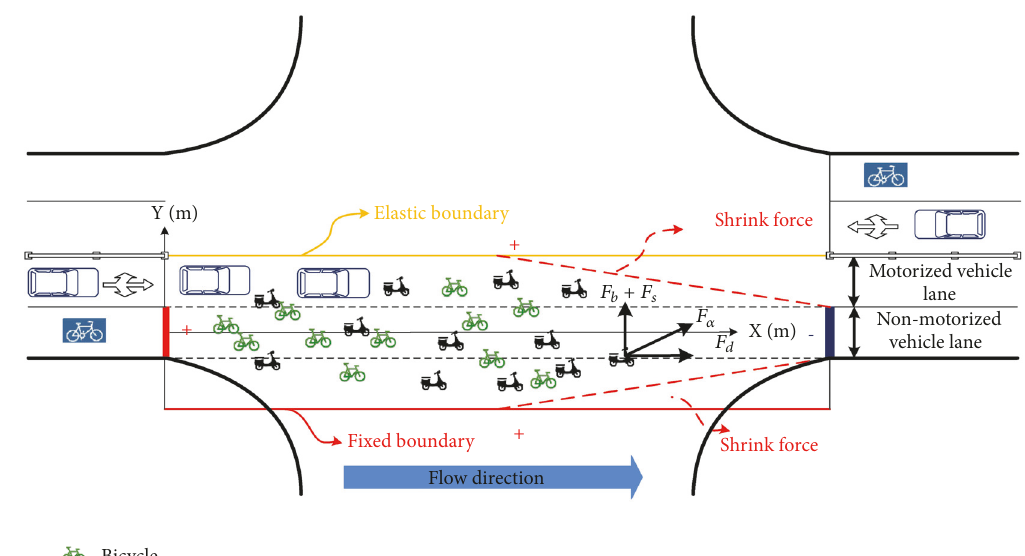
Figure 11: Forces in the dispersion